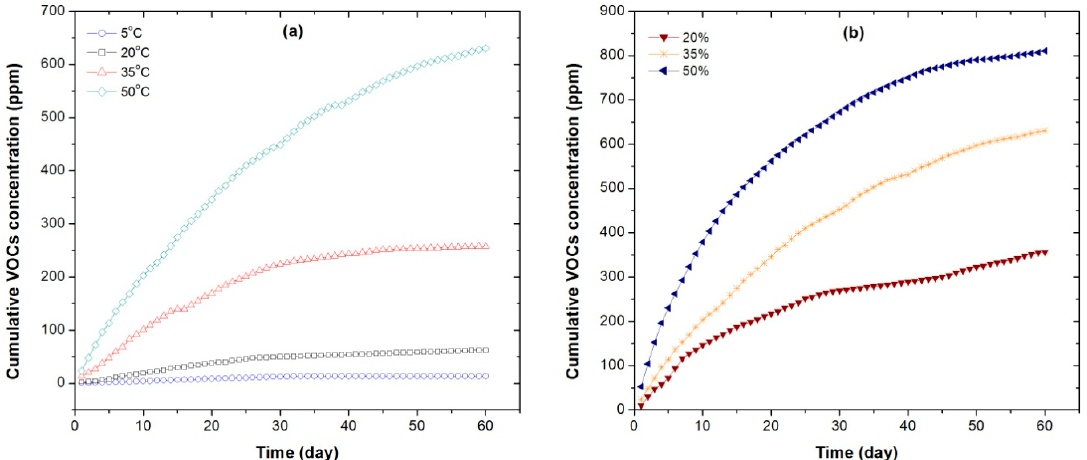
Figure 7. Cumulative total concentration of VOCs from aerobic reactors. ( a ) VOCs concentration from WRC chips with moisture content of 35% under different temperatures; ( b ) VOCs concentration from WRC chips with different moisture contents and storage temperature of 50 °C .